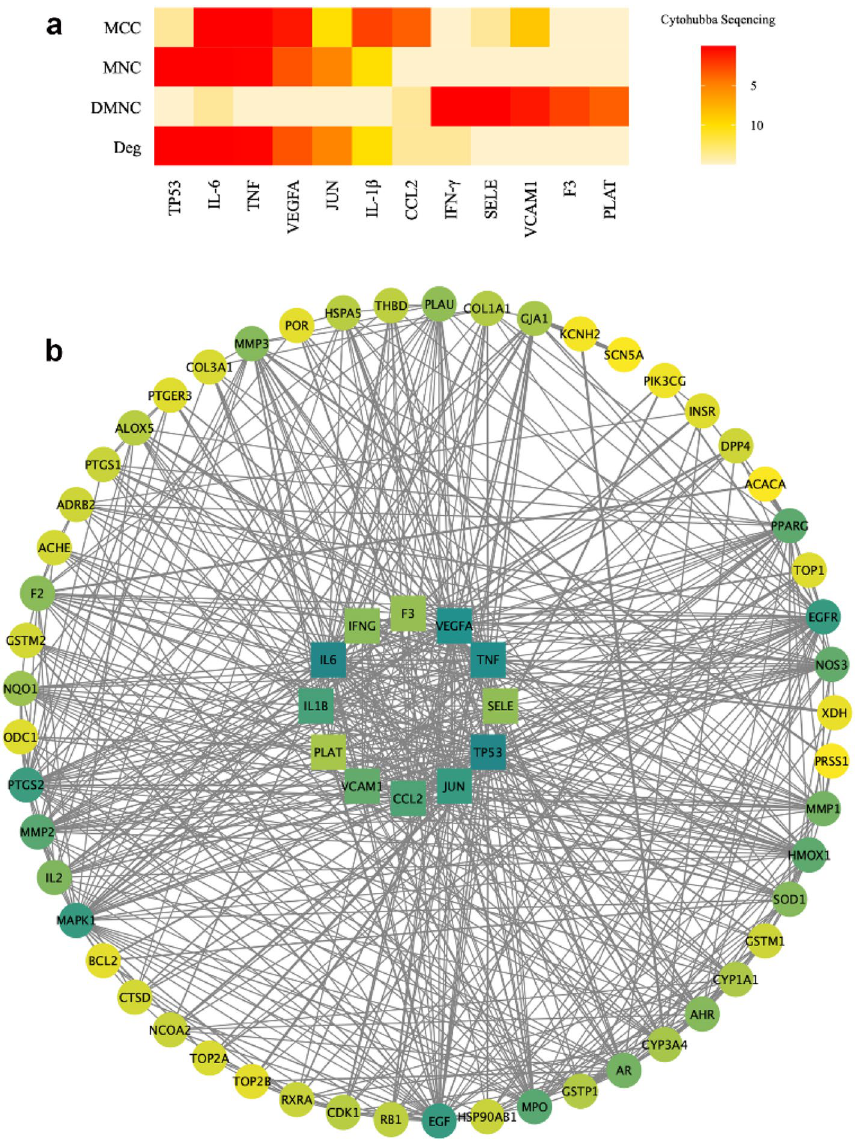
Figure 3. ( a ) Topological analysis was performed by the cytohubba tool. The four algorithms, maximum neighborhood component (MNC), density of maximum neighborhood component (DMNC), maximal clique centrality (MCC) and degree (Deg), were used as reference standards. The darker the color, the higher the sequence. The sequence of each common gene in the four algorithms were integrated. The abscissa represented 12 key common targets. ( b ) This was a protein–protein interaction (PPI) network graph, which showed the interrelationships between the 66 common targets. Each circle represented one common target. The color in the graph was adjusted according to the degree value. The deeper the color, the larger the degree value. The genes in the center of the circle were the 12 key genes that had been calculated using topological